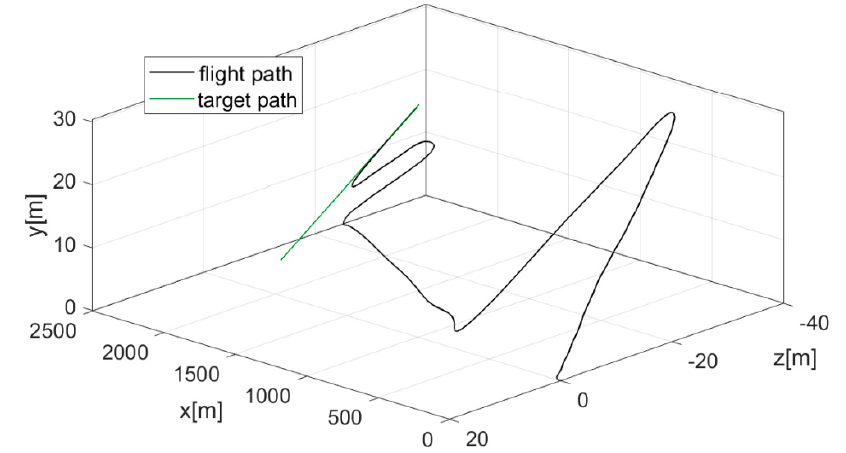
Figure 11. Implemented angle of attack α ( a ) and velocity of the ATGM ( b ) in function of time.